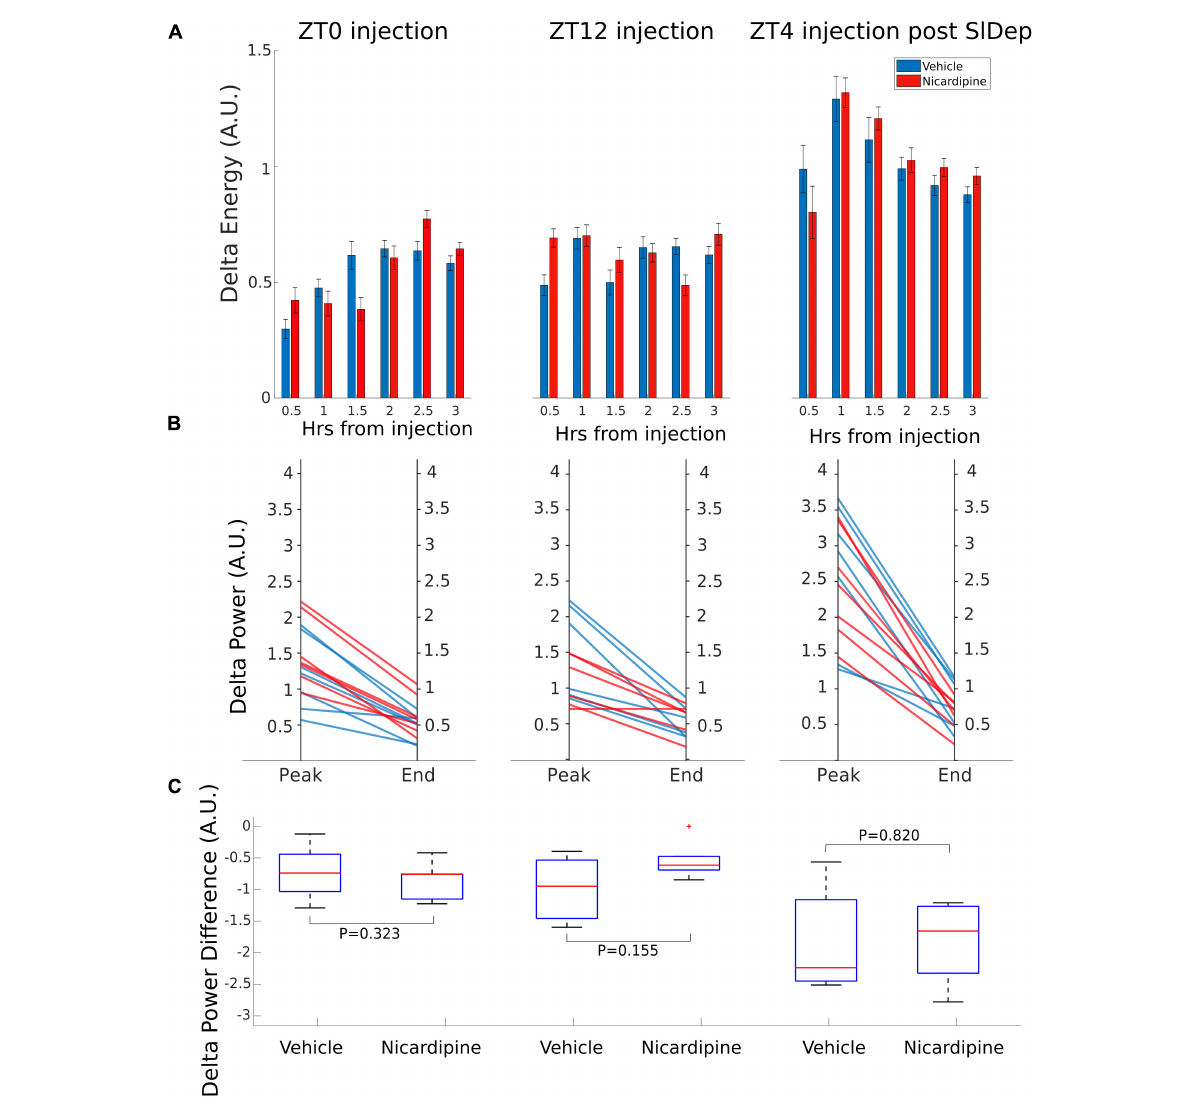
FIGURE3 Application of Nicardipine ICV does not Affect EEG Delta Oscillations. The power of EEG oscillations in the delta (0.5–4 Hz) band during NREM sleep did not differ when the animals received ICV vehicle injections or ICV nicardipine injections. (A) Power in the EEG delta band during NREM sleep is integrated over time to obtain delta energy. Delta energy production was measured for 3 h in three different conditions [at ZT0, at ZT12, and at ZT4 after 4 h of sleep deprivation (SlDep)]. Each animal was measured after vehicle injection (blue) and after nicardipine injection (red). Delta energy is plotted over time in 0.5-h bins. Nicardipine did not affect EEG delta energy in any of the three conditions at any time point. (B) The effectiveness of NREM sleep episodes can be measured by the reduction in EEG delta power over the duration of the episode. We analyzed NREM sleep episodes longer than 5 min in the recordings from ZT0, ZT12, and ZT4 after sleep deprivation. Peak EEG delta power within the first 3 min is plotted on the left-hand side, and the last epoch’s delta power is plotted on the right-hand side. After both vehicle treatment (blue) and nicardipine treatment (red), EEG delta power was lower at the end of the episode compared to the beginning. (C) Box plots (orange line, mean; blue box 25th percentile; black whiskers 90th percentile) of comparison between vehicle treatment and nicardipine treatment on the average reduction in delta power during NREM sleep episodes longer than 5 min. In all three conditions, there was no significant difference between vehicle and nicardipine. P -values were obtained with paired two-tailed Student’s t -test ( N =